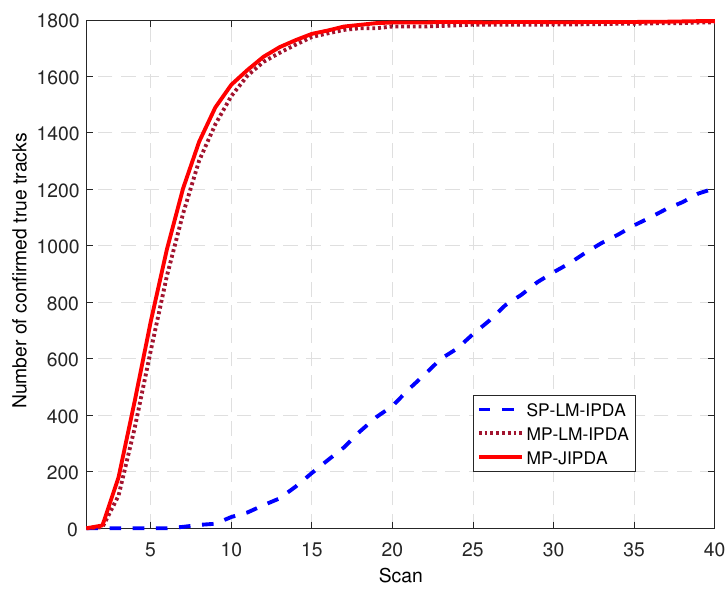
Figure 12. Number of confirmed true tracks for all targets.